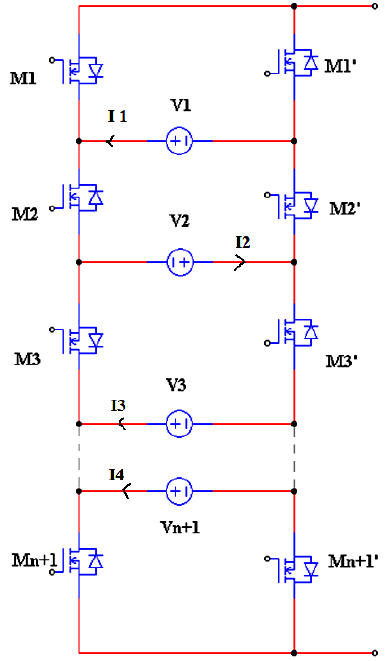
Figure 48. Circuit diagram for switched DC-source MLI.